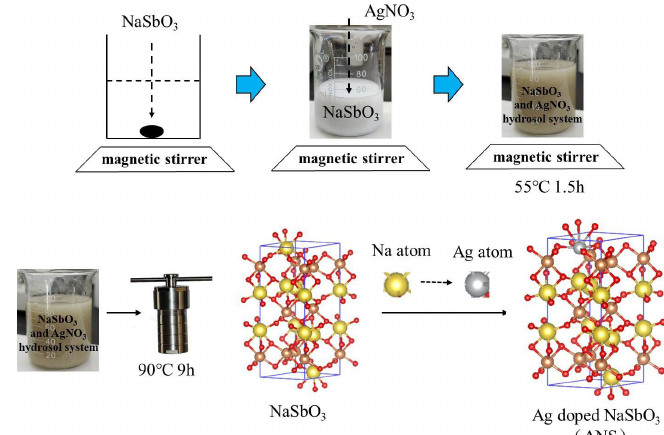
Figure 1. The schematic illustration of the synthesis